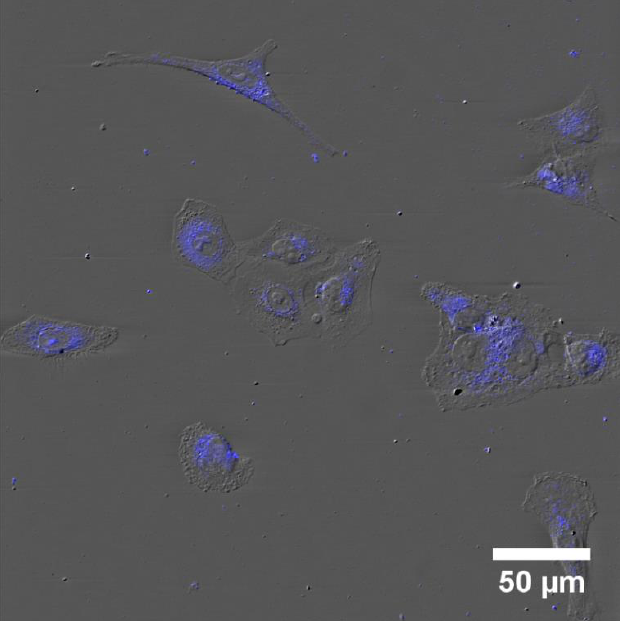
Figure 15. Cellular internalization of CQDs in A549 cells.